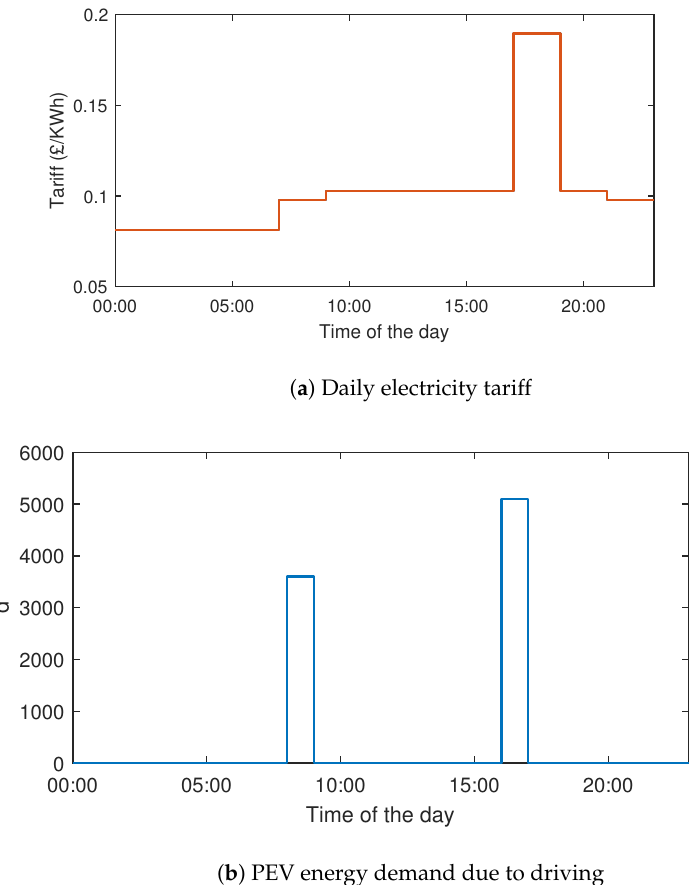
Figure 5. Electricity tariff and energy demand.